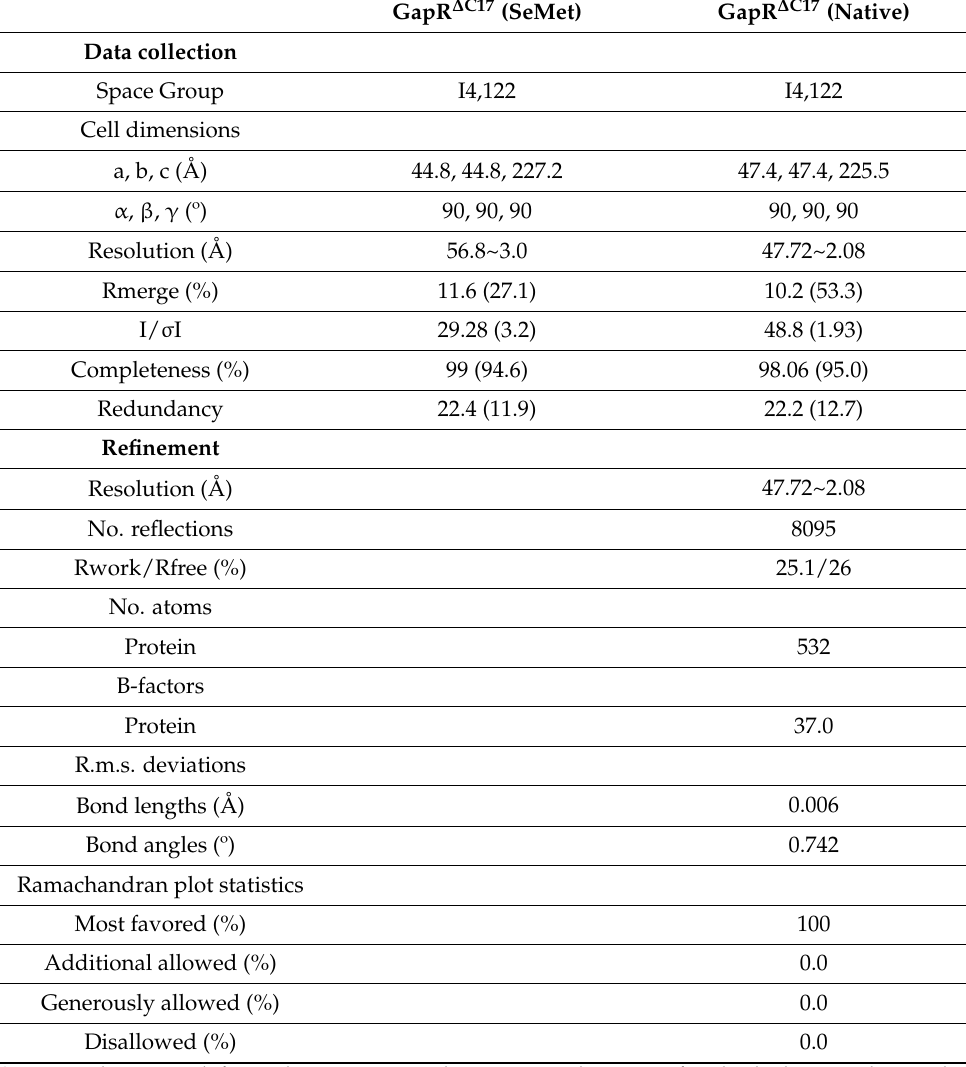
Table 1. Data collection and refinement statistics of the crystal structure of GapR ∆ C17